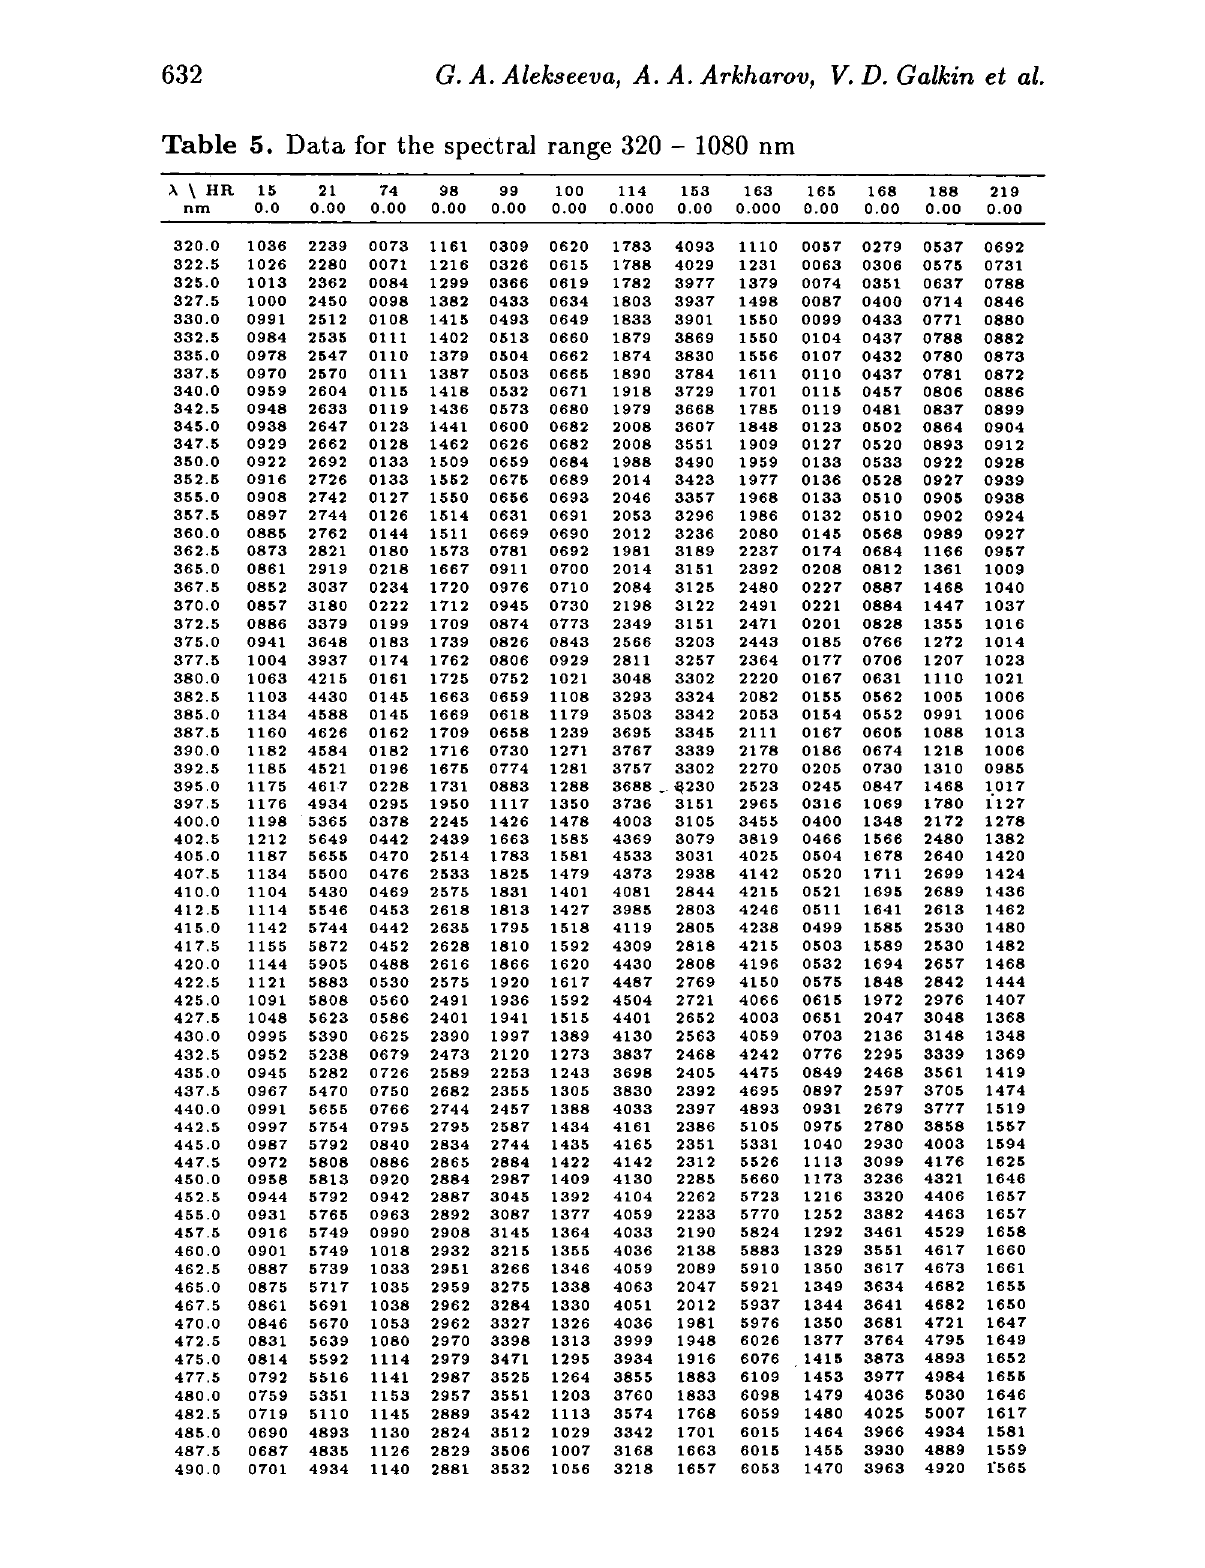
Table 5. Data for the spectral range 320 - 1080